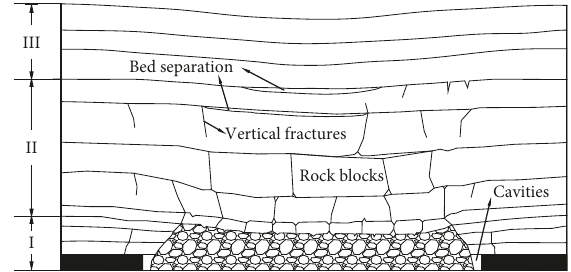
Figure 1: Zones of overlying strata movement by longwall mining: I, caved zone; II, fracture zone; III, continuous deformation